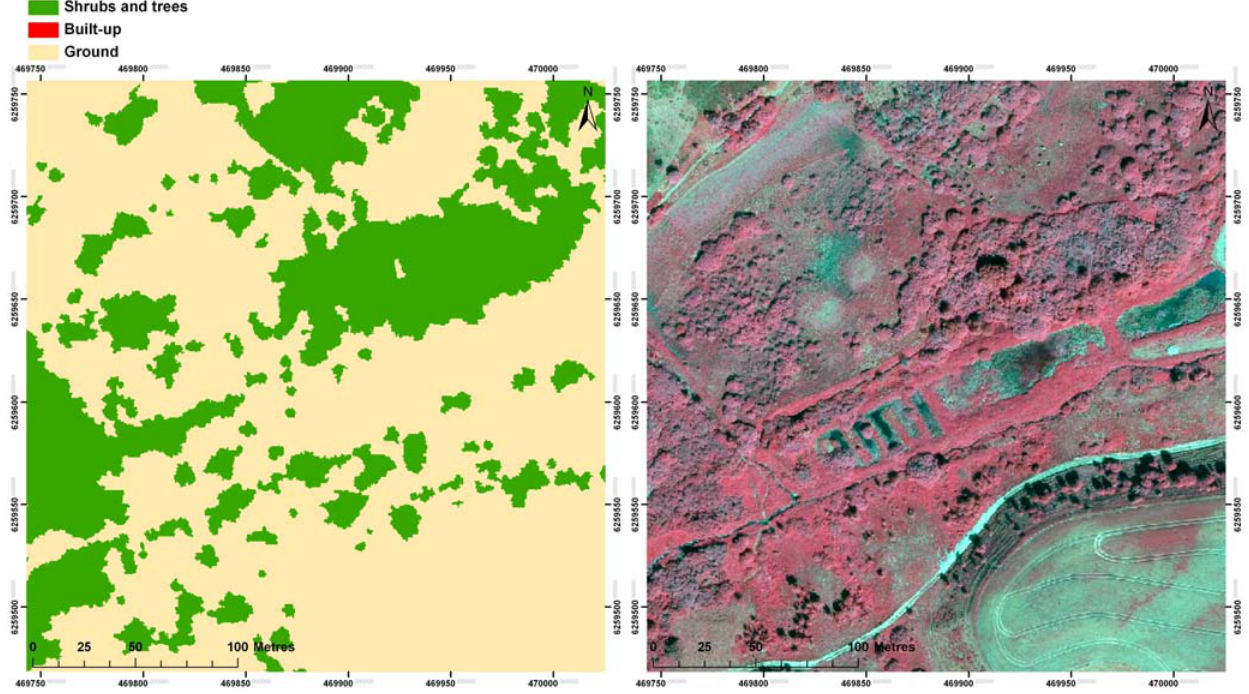
Figure 15. This example (2) shows that the nDSM combined with the CIR orthoimages and the SUM/NIR feature has effectively classified and outlined the shrubby